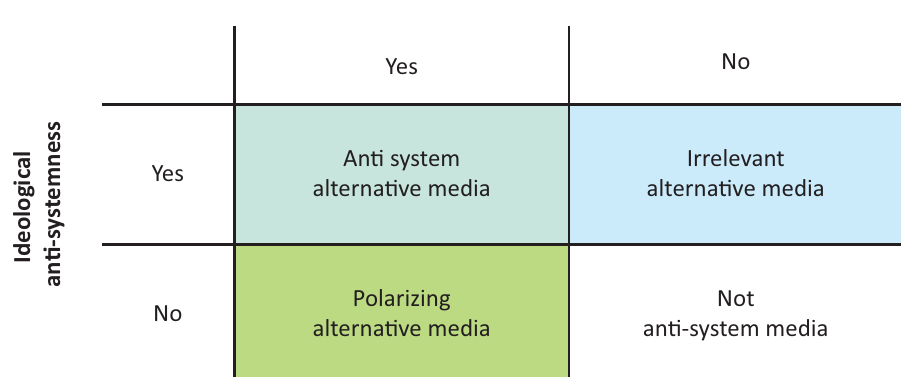
Figure 1. The Alternative Media Anti-systemness Matrix. Based on Capoccia’s (2002) typology of “anti-system parties”. The 2 × 2 matrix displays a typology of alternative media and their different forms of anti-systemness (or lack thereof) in relation to traditional media’s positions, norms and ways of